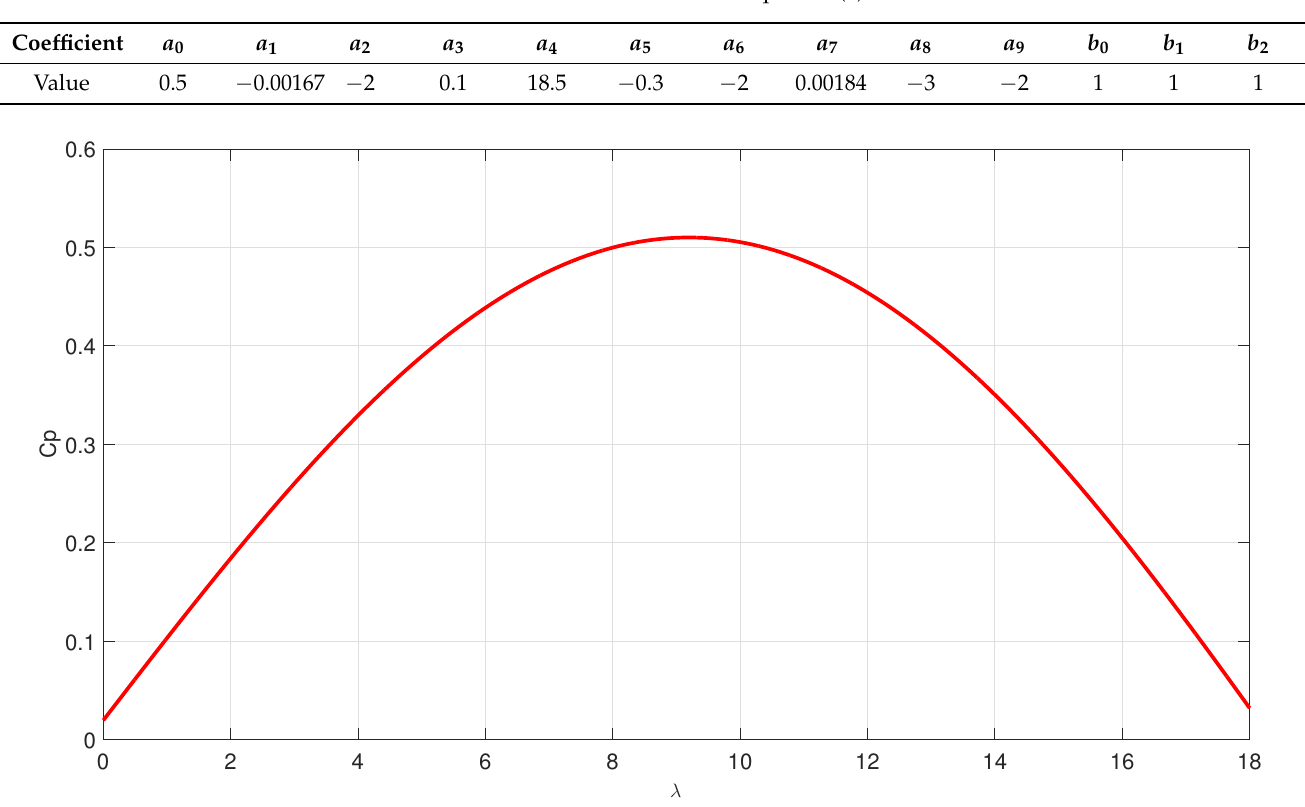
Table 1. Coefficients values for Equation (3).